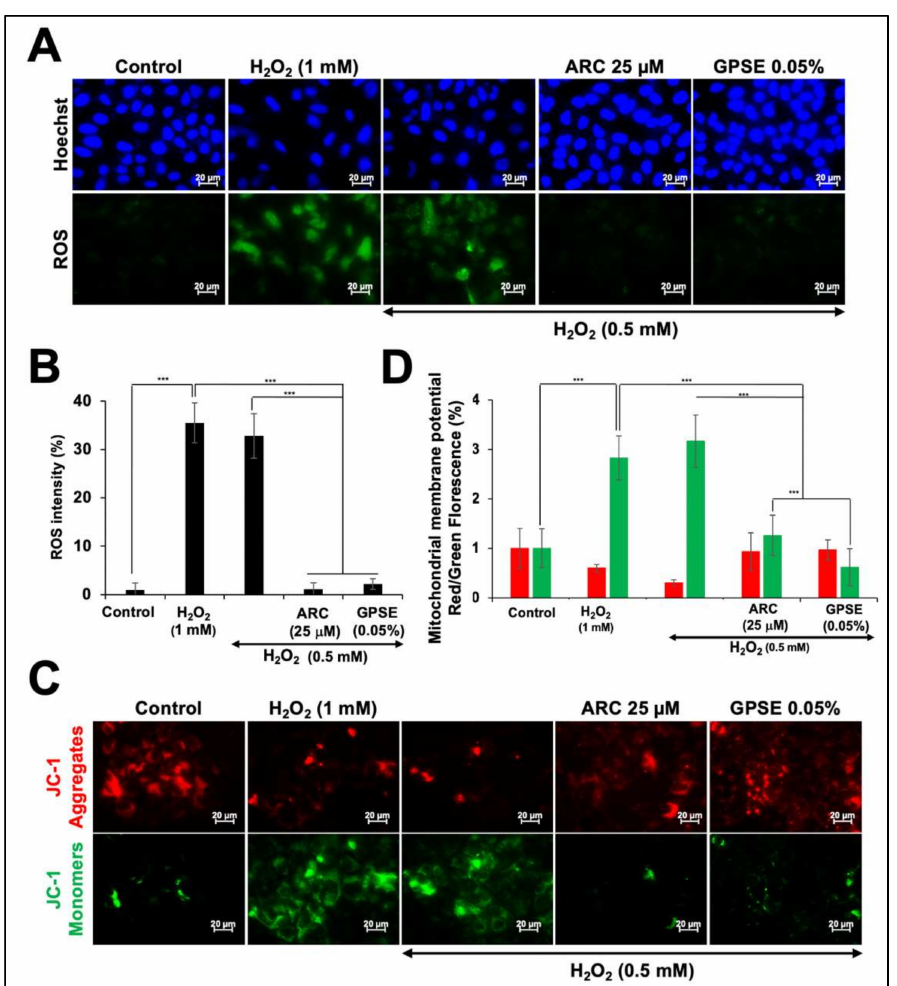
Figure 6. Low dose of GPSE protected the cells against oxidative stress: Control and treated cells subjected to ROS and JC-1 staining assays showed increased in ROS with H 2 O 2 -induced oxidative stress and its remarkable decrease in ARC- and GPSE-treated cells ( A , B ). JC-1 staining as examined by JC-1 dye (ab141387) showed loss of mitochondrial potential, as indicated by decrease in red